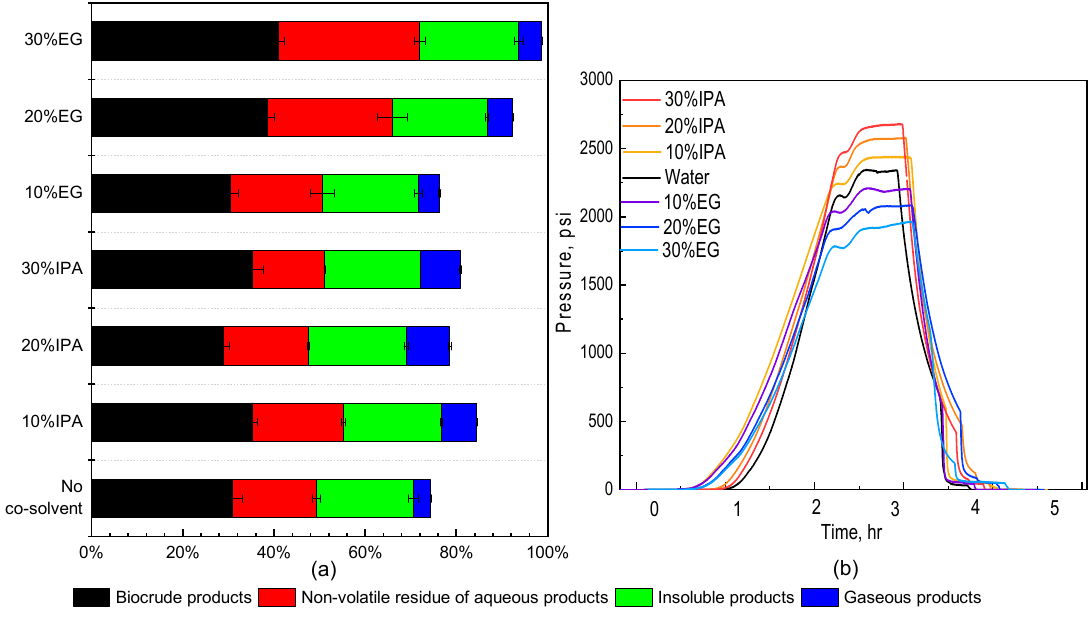
Figure 7. Effects of co-solvent concentration on product yields ( a ) and reaction pressures ( b ) during liquefaction of Tetraselmis sp. at 350 °C. (IPA: Isopropyl alcohol; EG: Ethylene glycol). Error bars represent standard deviation from duplicate experiments.